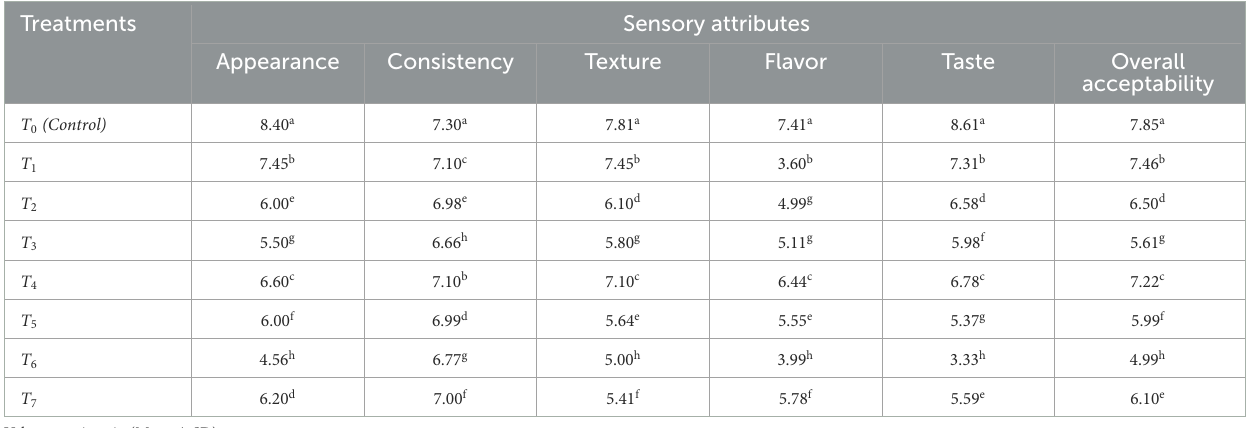
Valuesaregivenin(Mean ± SD). Meansthatdonotsharealetterinarowaresignificantlydifferentatlevel(p < 0.05). T0 = 0%control. T1 = 3%SPP.